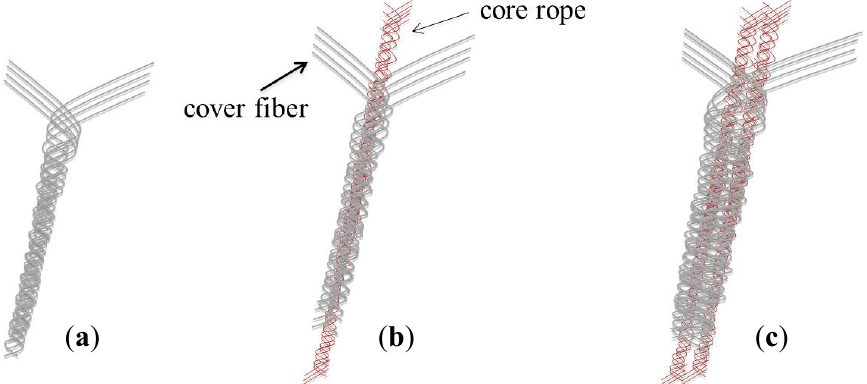
Figure 10. The illustration of the braided ropes. Original PLA fibers were braided as a core rope. P-3 as a cover fiber was braided around the core rope. ( a ) Non-; ( b ) single-; and ( c ) double-core braided ropes were prepared.